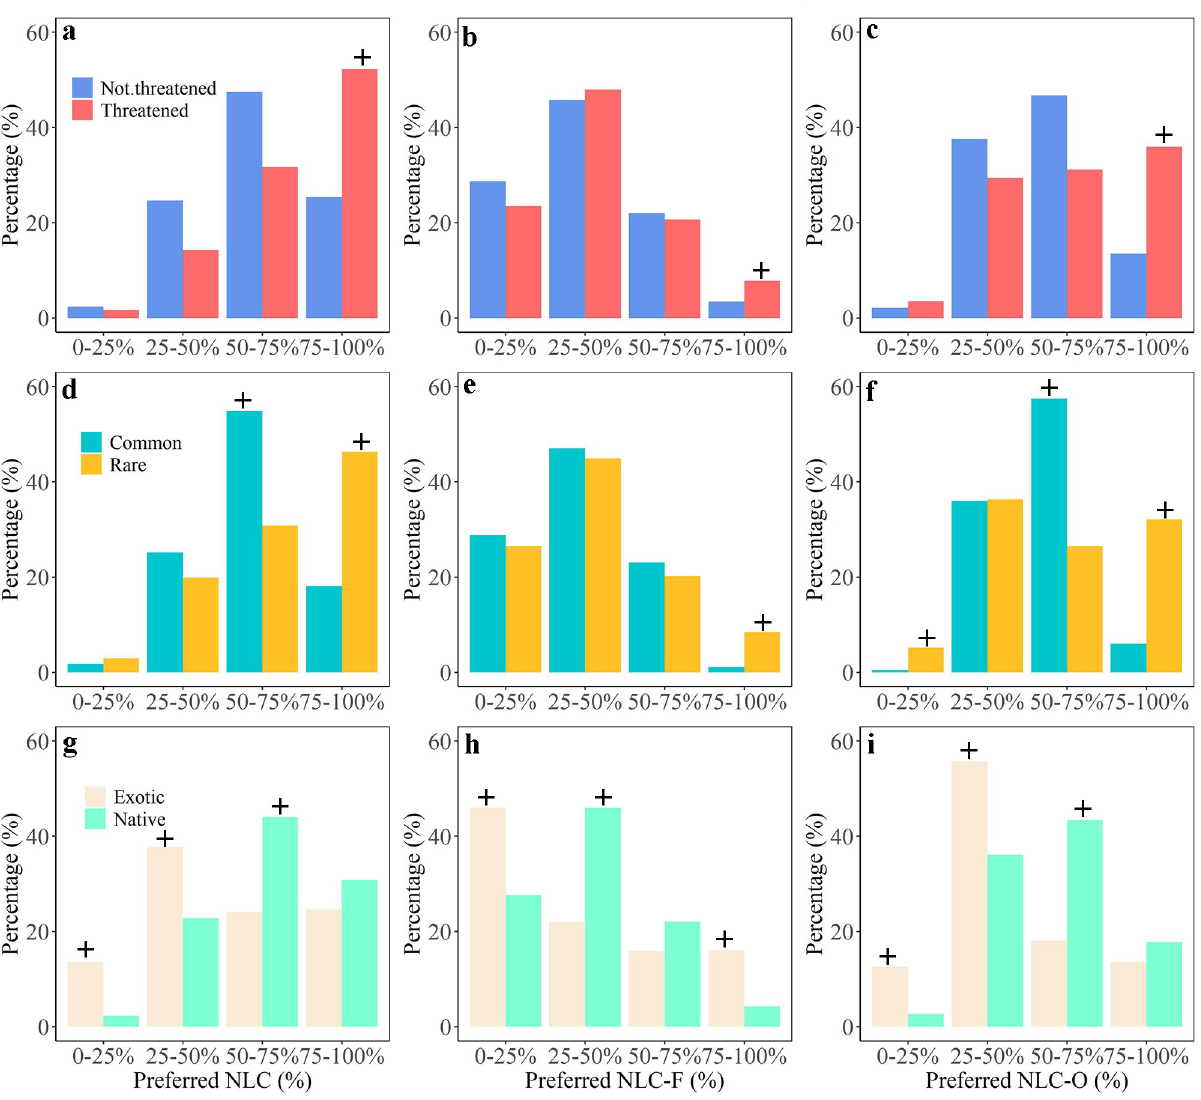
Fig 6. Percentage distribution of species along the preferred NLC, preferred NLC-F and preferred NLC-O within each species category (threatened status, rarity and origin of species). a-c, Percentage distribution of threatened and not threatened species along preferred NLC (a), NLC-F (b) and NLC-O (c). d-f, Percentage distribution of common and rare species along preferred NLC (d), NLC-F (e) and NLC-O (f). h-i, Percentage distribution of native and exotic species along preferred NLC (g), NLC-F (h) and NLC-O (i). ‘+’ indicates values that are above expectation according to our Contingency Analysis (see supplementary analysis for detailed